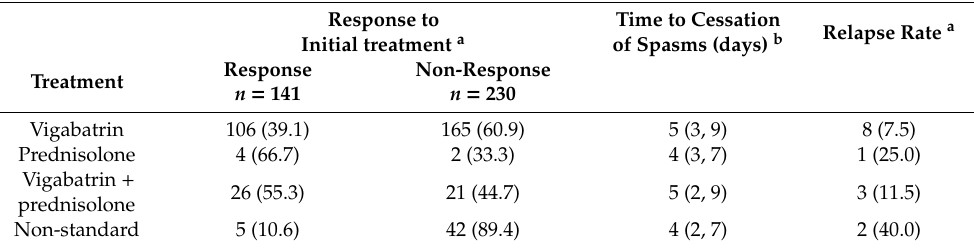
Table 2. E ff ect of first-line treatment on